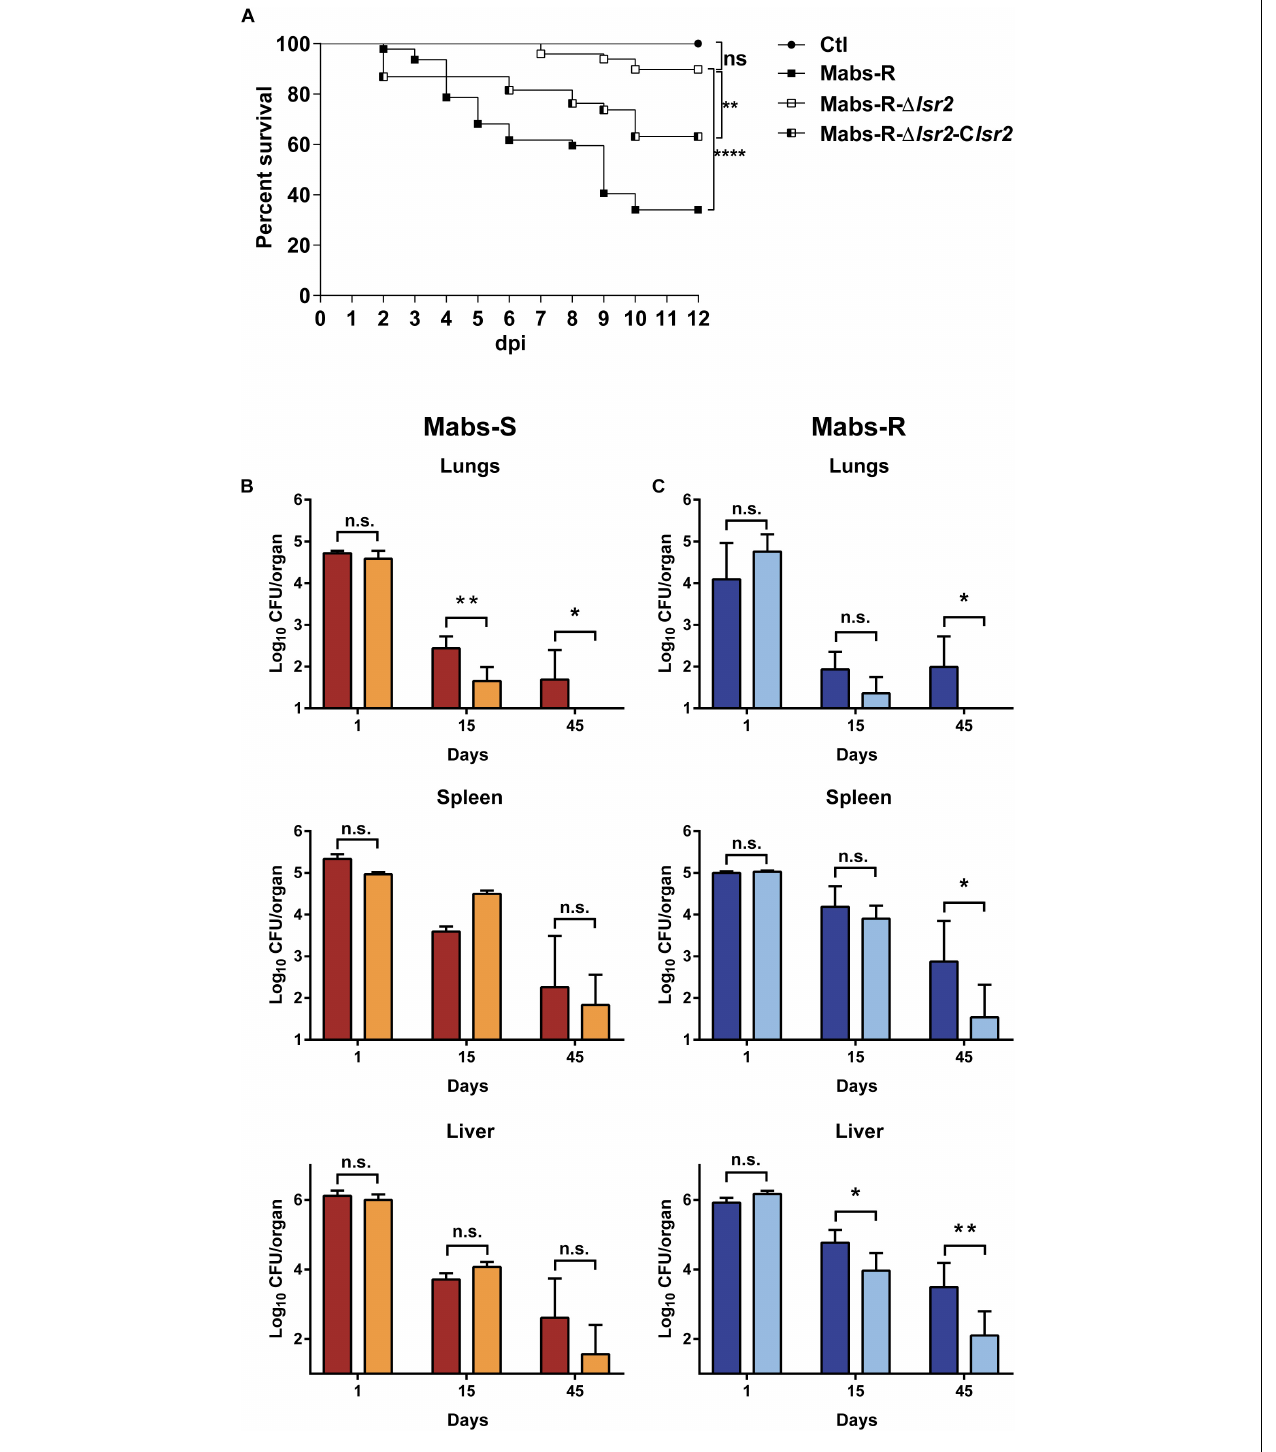
FIGURE 6 | Lsr2 is required for survival of M. abscessus in zebrafish and mice. (A) Survival curve of infected embryos with 50–164 CFU of Mabs-R ( n = 47 embryos), 160–282 CFU of Mabs-R- (cid:49) lsr2 ( n = 49 embryos) and 149–290 CFU of the complemented strain ( n = 37 embryos). Experiments were done twice. Significant differences were obtained using the Log-rank (Mantel-Cox) statistical test; ∗∗ P < 0.01 and ∗∗∗∗ P < 0.0001. (B,C) Comparative analysis of bacterial burden in different organs after autopsy of BALB/c mice infected intravenously with 10 6 CFU of Mabs-S (in red) and Mabs-S- (cid:49) lsr2 (orange) (B) or Mabs-R (dark blue) and Mabs-R- (cid:49) lsr2 (light blue) (C) in the lungs, spleen and liver at 1, 15, and 45 dpi. Student’s t -test and Fisher’s exact test were used. A P -value of 0.05 was considered significant ( ∗ P < 0.05 and ∗∗ P < 0.01).